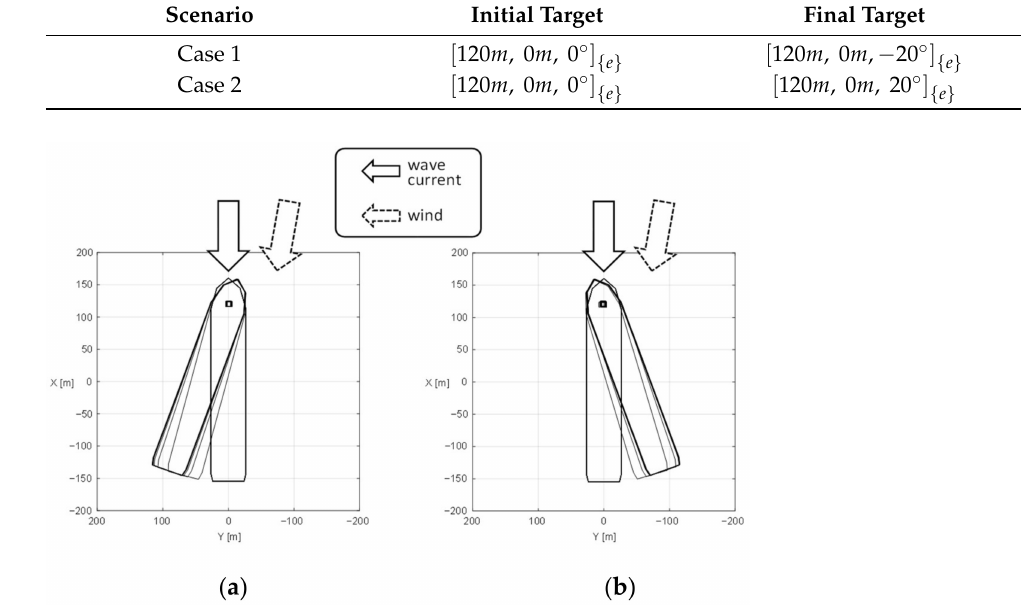
Figure 10. Control scenarios for dynamic positioning of a vessel with environmental disturbance: ( a ) clockwise and ( b ) counter-clockwise DP control.